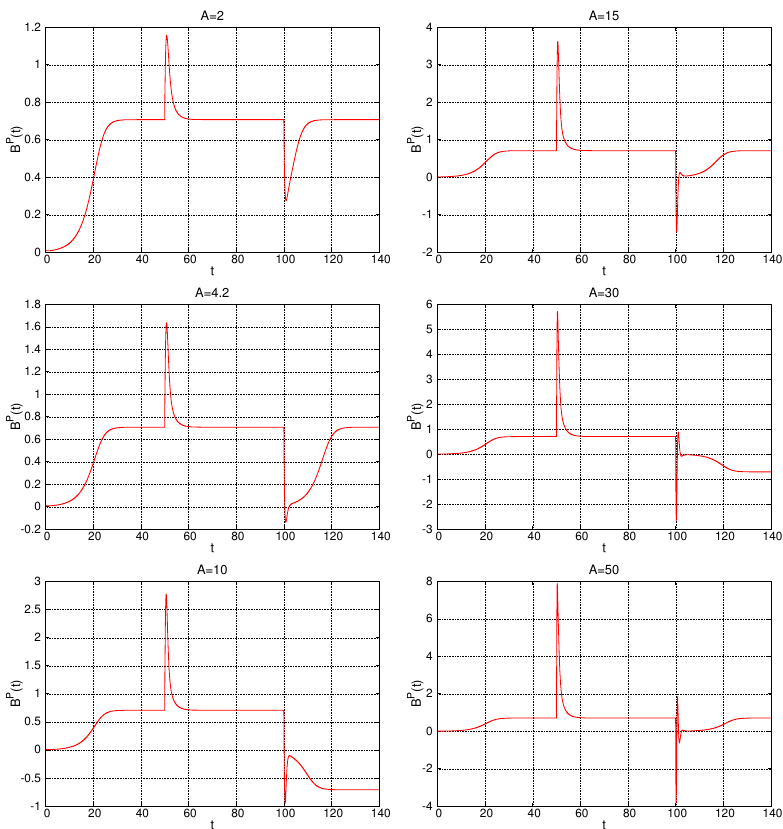
Figure 1. The response of the poloidal component B P (t) on the regular sequence of alternating pulses with different amplitudes A .